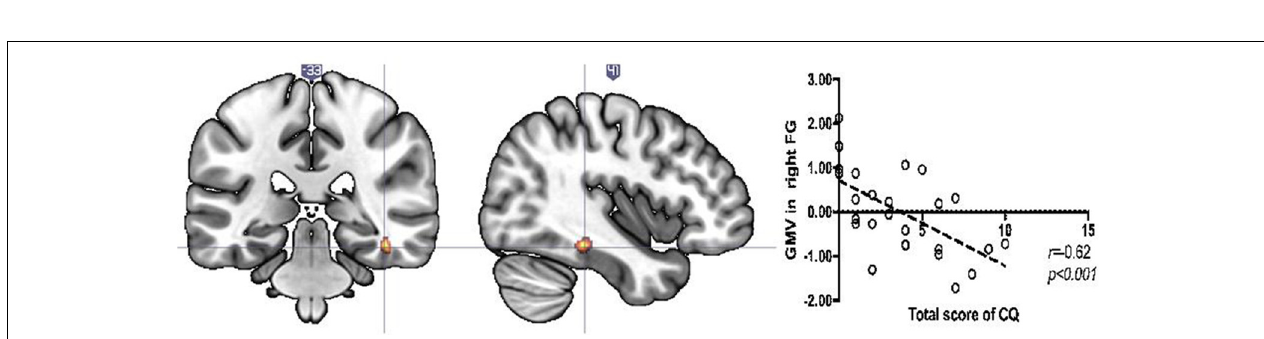
FIGURE 1 | Significant decrease in regional gray matter volume (GMV) related to Childhood Questionnaire (CQ) score in the (A) left inferior parietal lobule (IPL), (B) right precentral gyrus, and (C) right cerebellum in the female sample. Scatterplots illustrate relationships between CQ score and GMV (for display purposes only). The x -axis of the scatterplot represents standardized residuals of GMV and the y -axis represents the total score of CQ. For standardized residual measures, age and total intracranial volumes were regressed out.